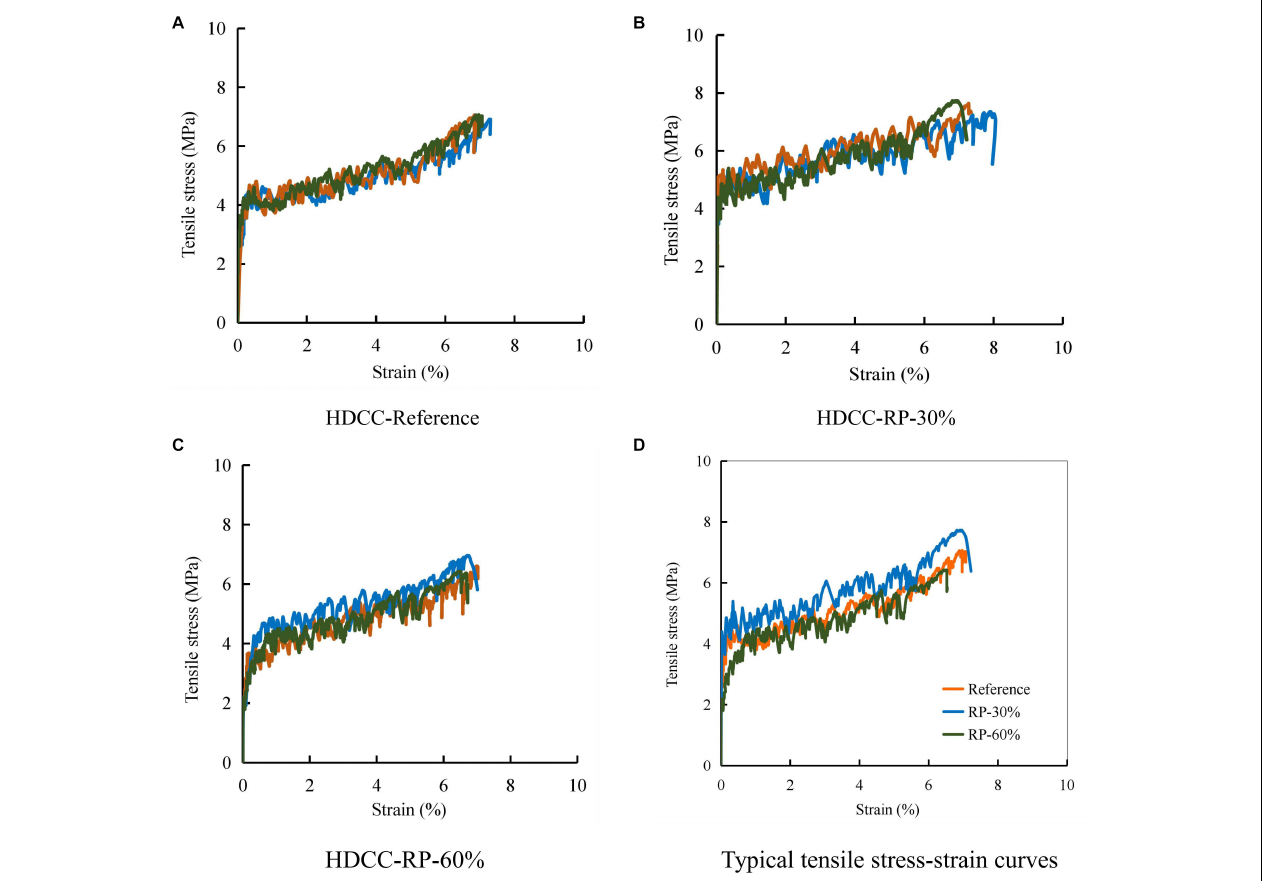
FIGURE 8 | Tensile stress-strain curves of HDCCs. (A) HDCC-Reference. (B) HDCC-RP-30%. (C) HDCC-RP-60%. (D) Typical tensile stress-strain curves.